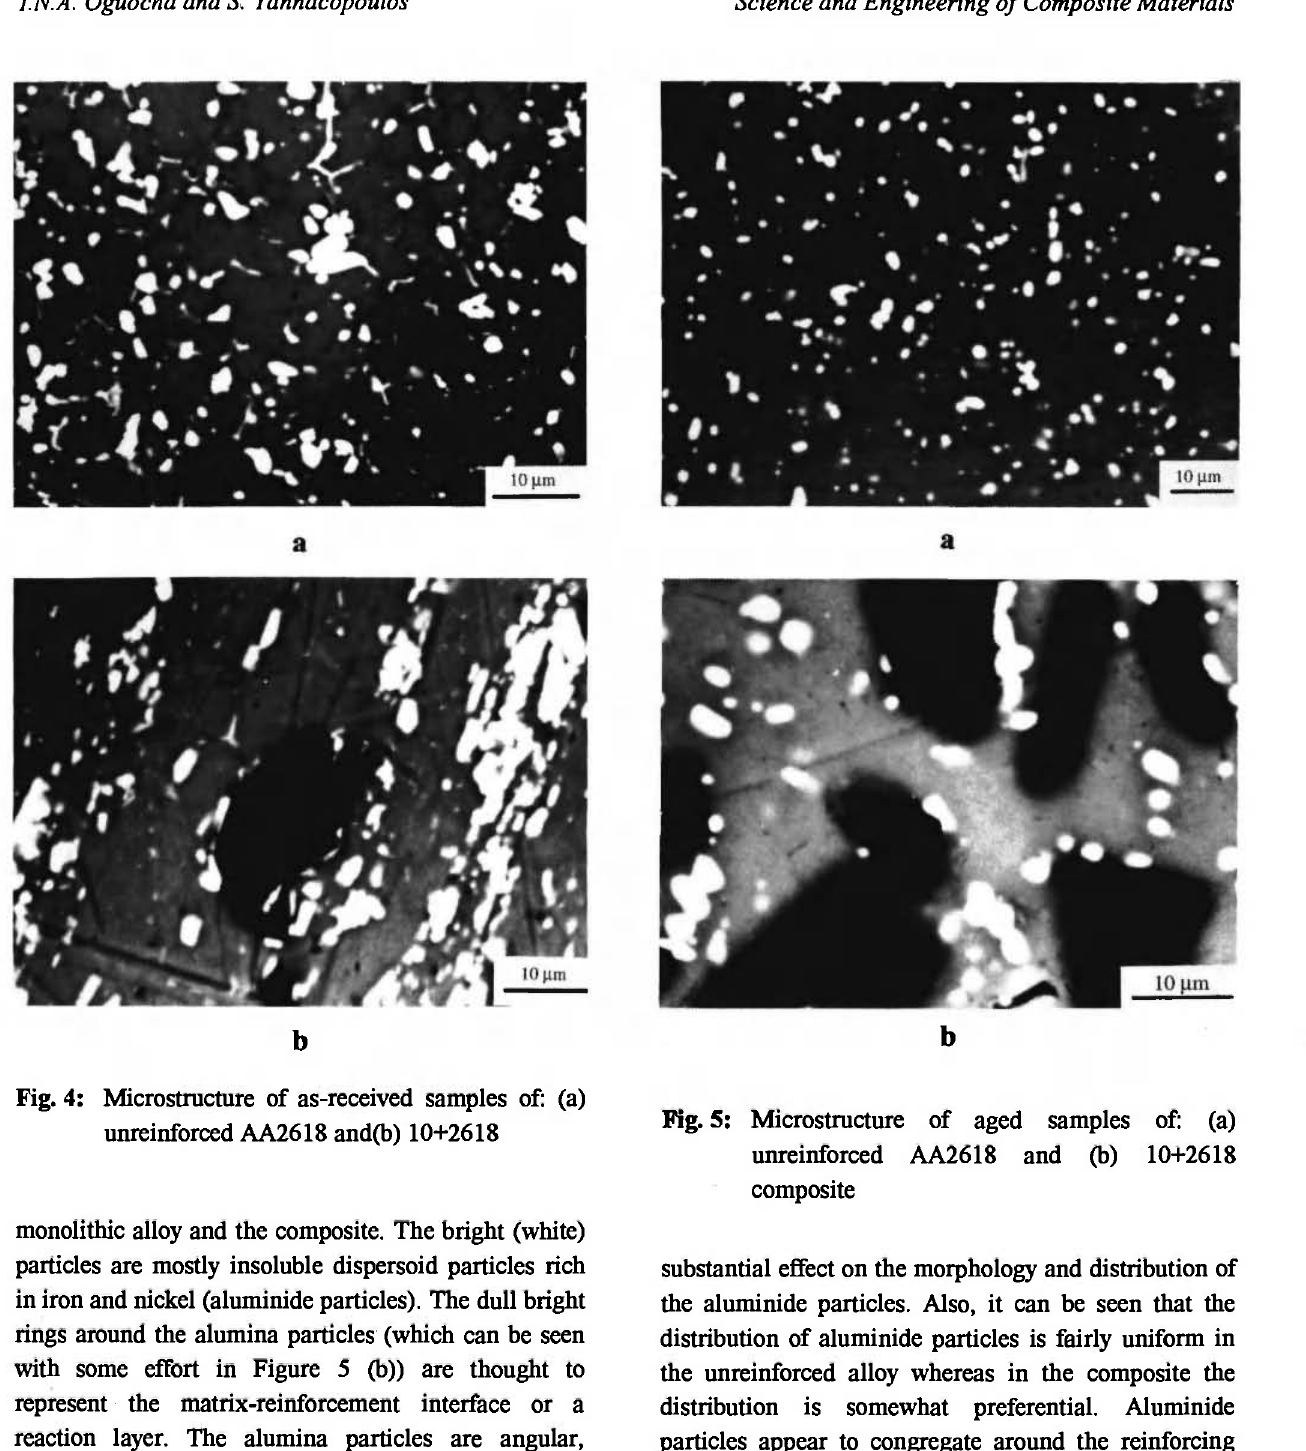
Fig. 4: Microstructure of as-received samples of: (a) unreinforced AA2618 and(b) 10+2618